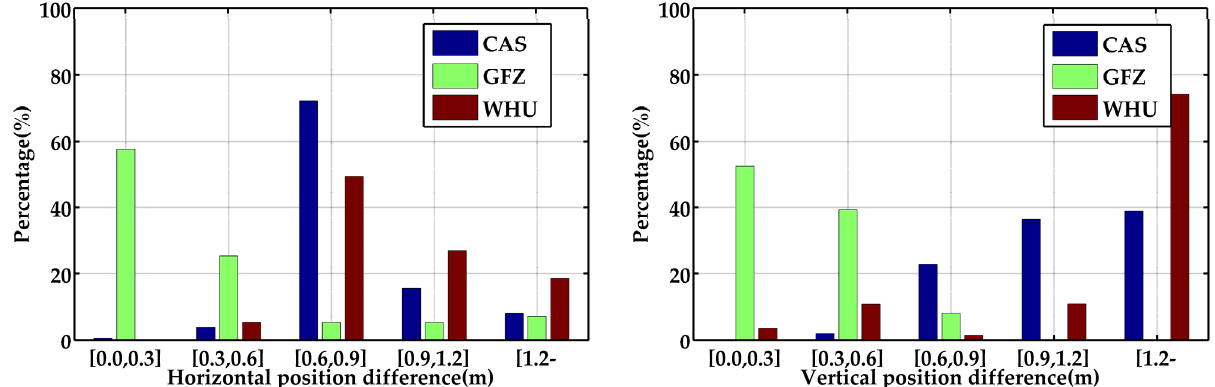
Figure 8. Position differences of G + B SF-PPP/INS tight integration in the three directions using the real-time products from CAS, GFZ, and WHU (the start time is 195,453 s).